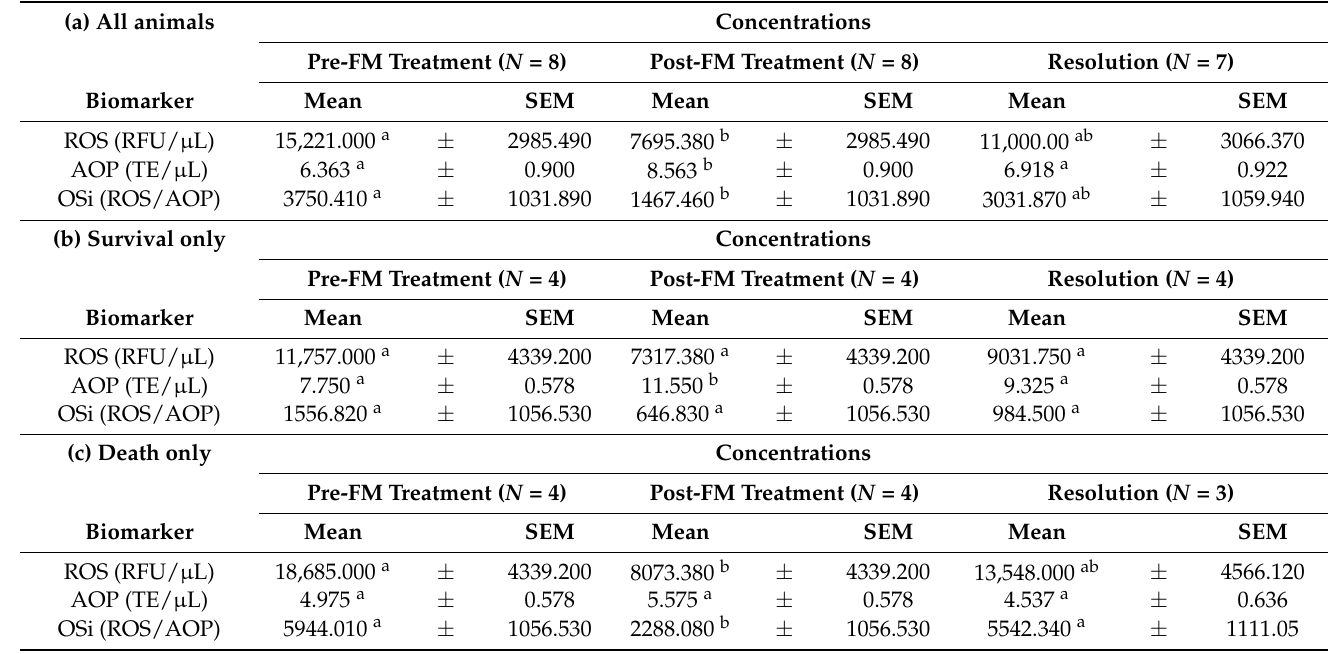
Table 2. Milk biomarkers of oxidant status over the course of systemic coliform mastitis with FM treatment in Holstein cows. (a) All